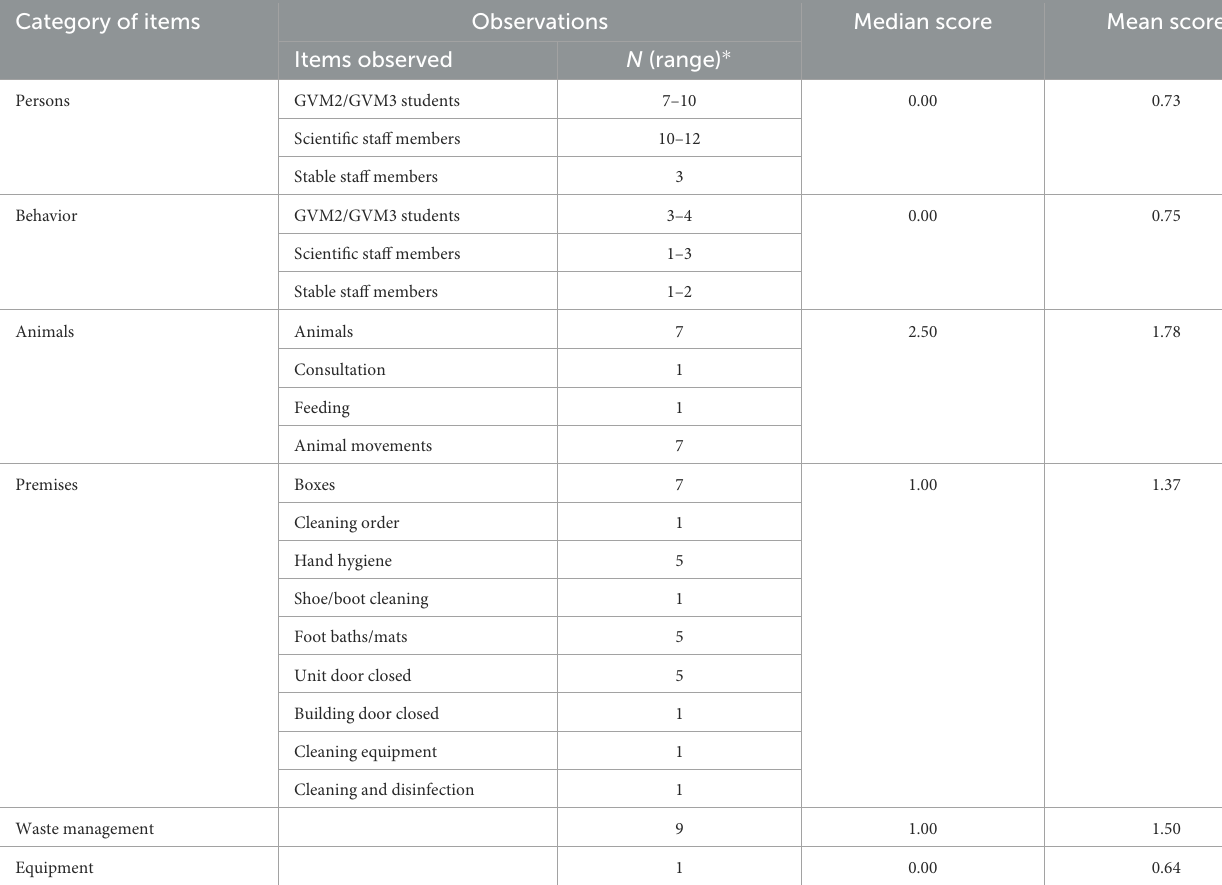
TABLE 1 Class 3 of the Equine Clinic—mean and median scores per category of items. Category of